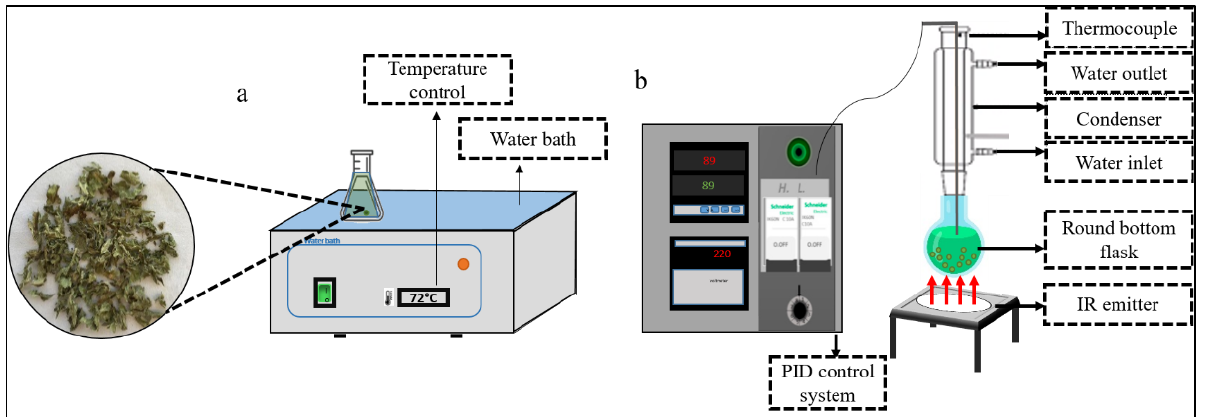
Figure 6. Experimental setup of water bath ( a ) and Infrared ( b ) equipment.